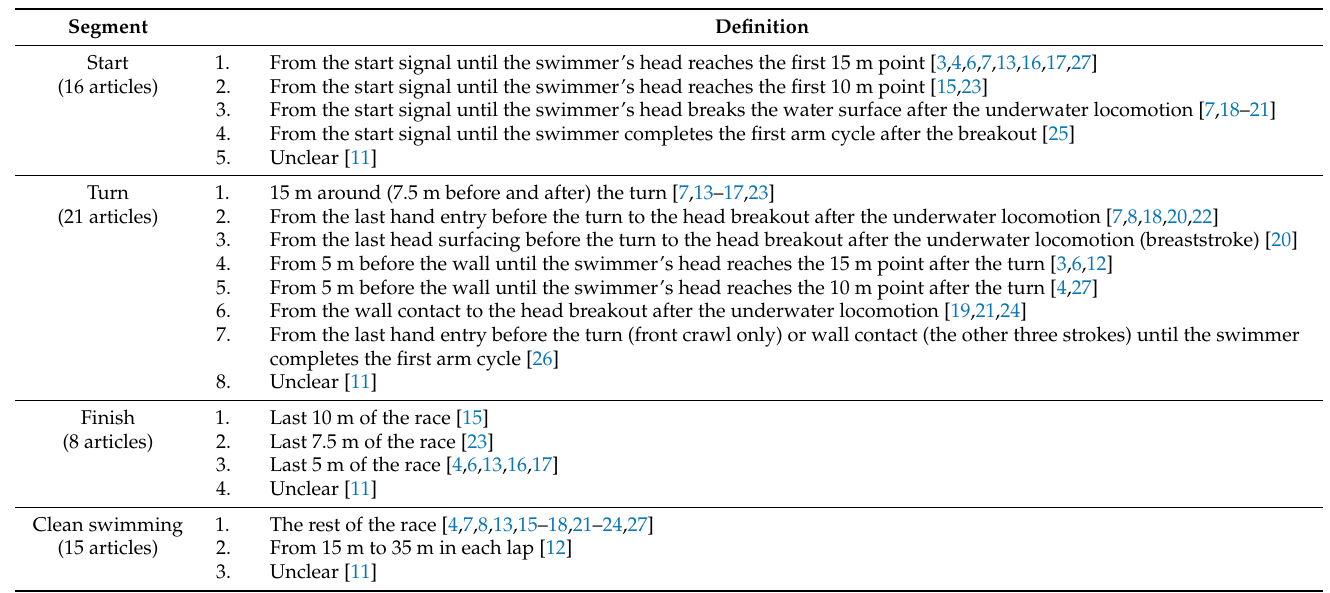
Table 1. Segment definitions used in the reviewed literature.